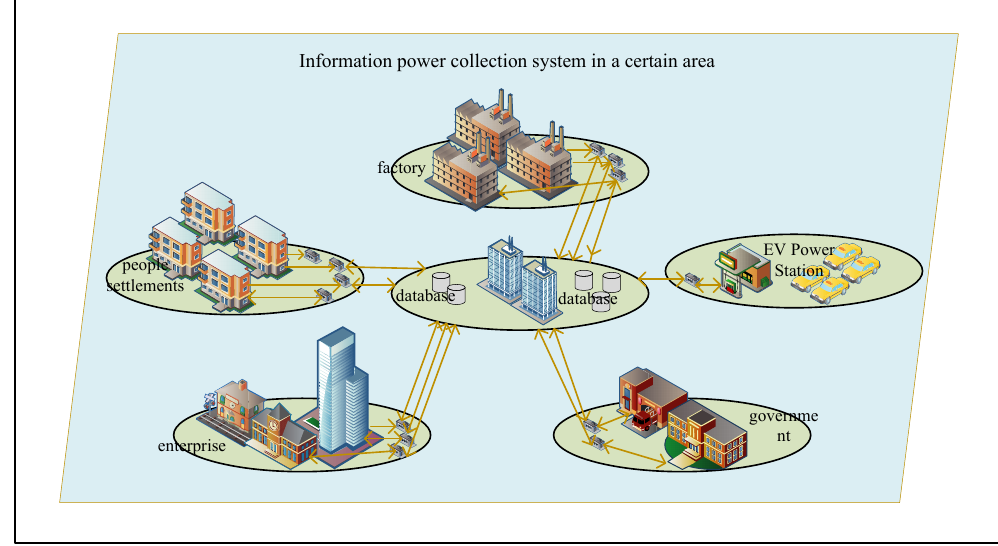
Figure 2. The information collection system of the power